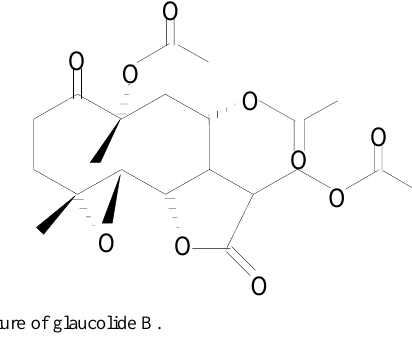
Figure 1 - Structure of glaucolide